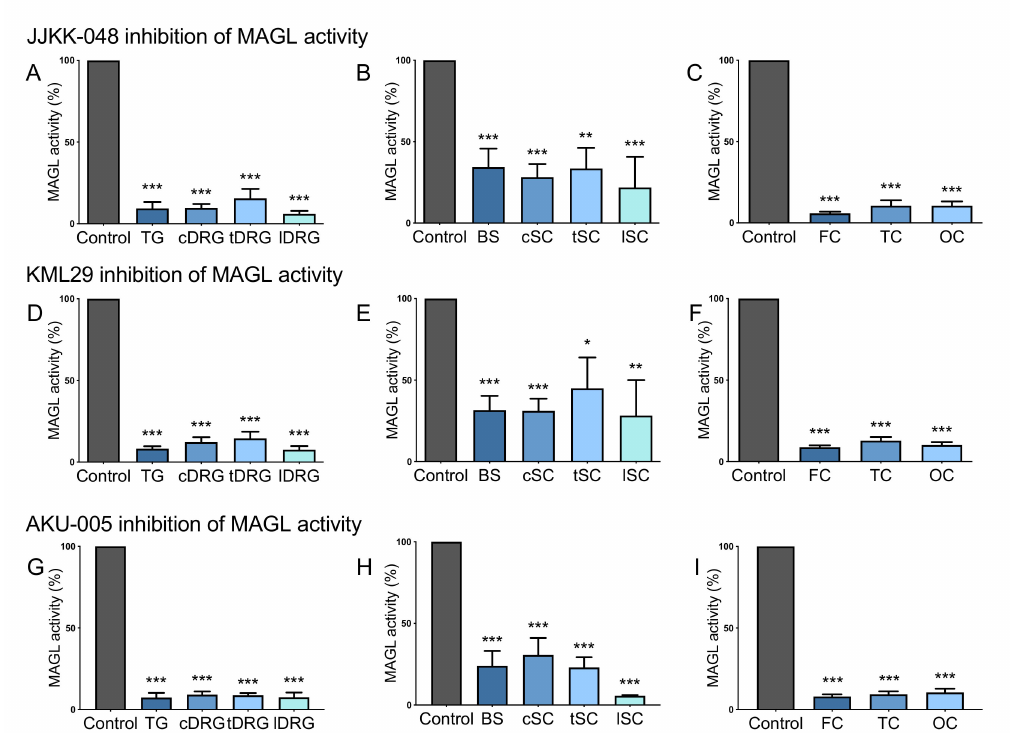
Figure 5. The blocking capacity of the MAGL inhibitors JJKK-048, KML29 and the dual MAGL-FAAH inhibitor AKU-005 in the CNS and the PNS. ( A ) JJKK-048 (100 nM) almost completely inhibited MAGL activity at peripheral level: by 90% in TG and cervical DRG (cDRG), 85% in thoracic DRG (tDRG) and 95% in lumbar DRG (lDRG). ( B ) JJKK-048 (100 nM) inhibited MAGL activity by 66% in brainstem (BS), 72% in cervical spinal cord (cSC), 68% in thoracic spinal cord (tSC), 79% in lumbar spinal cord (lSC). ( C ) JJKK-048 (100 nM) inhibited MAGL activity by 95% in frontal cortex (FC) and 90% in temporal and occipital cortexes (TC and OC). ( D ) KML29 (1 µ M) strongly reduced MAGL activity at peripheral level: 92% TG, 88% cDRG, 86% tDRG, 93% lDRG. ( E ) KML29 (1 µ M) inhibitory effect on brainstem and cSC was 69%, in tSC 55% and 72% in lSC. ( F ) KML29 (1 µ M) strongly reduced MAGL activity at cortical level: by 92% in FC, 88% in TC, 90% in OC. ( G ) AKU-005 (1 µ M) reduced MAGL basal activity at peripheral level: 93% in TG, 91% in cDRG, 92% in tDRG and 93% in lDRG. ( H ) AKU-005 (1 µ M) inhibited basal MAGL activity also in brainstem (77%) and spinal cord (70% cSC, 78% tSC, 95% lSC). ( I ) AKU-005 (1 µ M) inhibitory effect on cortical MAGL activity was of 92% in FC, 91% in TC and 90% in OC. One-way ANOVA with Tukey’s multiple comparison post-hoc test was used for statistical analysis between the MAGL activities after control (DMSO) and inhibitor treatments, (* p < 0.05, ** p < 0.01, *** p < 0.001). For JJKK-048: n = 8 (TGs, DRGs), n = 11 (BS, cSC), n = 8 (tSC, lSC) and n = 9 (cortex); For KML29: n = 8 (TGs, DRGs), n = 11 (BS, cSC), n = 8 (tSC, lSC) and n = 9